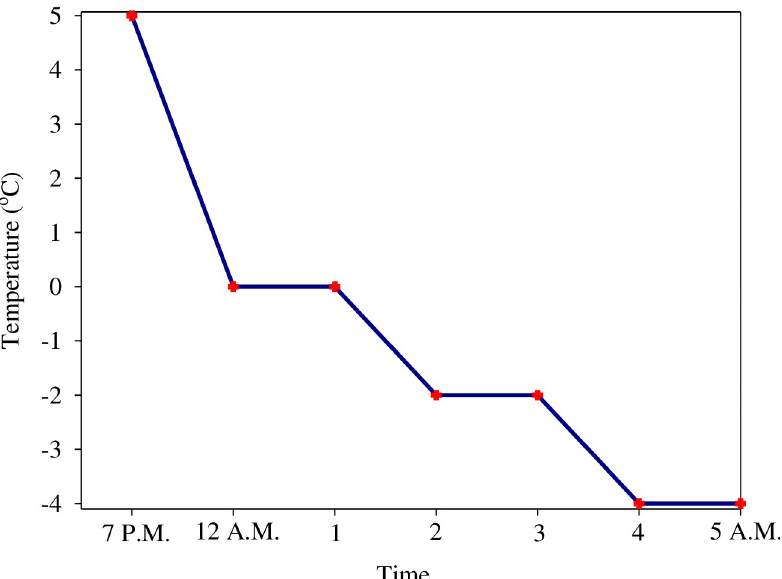
Each morning at 5:30 A.M., the plants were transferred out of the freezer, kept in natural conditions until 6:30 P.M., and then returned to the freezer during the night. After three nights of freezing exposure, the pots were taken out of the freezer and sprayed with herbicides after 2 h [19]. After spraying, the plants were kept outside under natural conditions for the duration of the experiment.